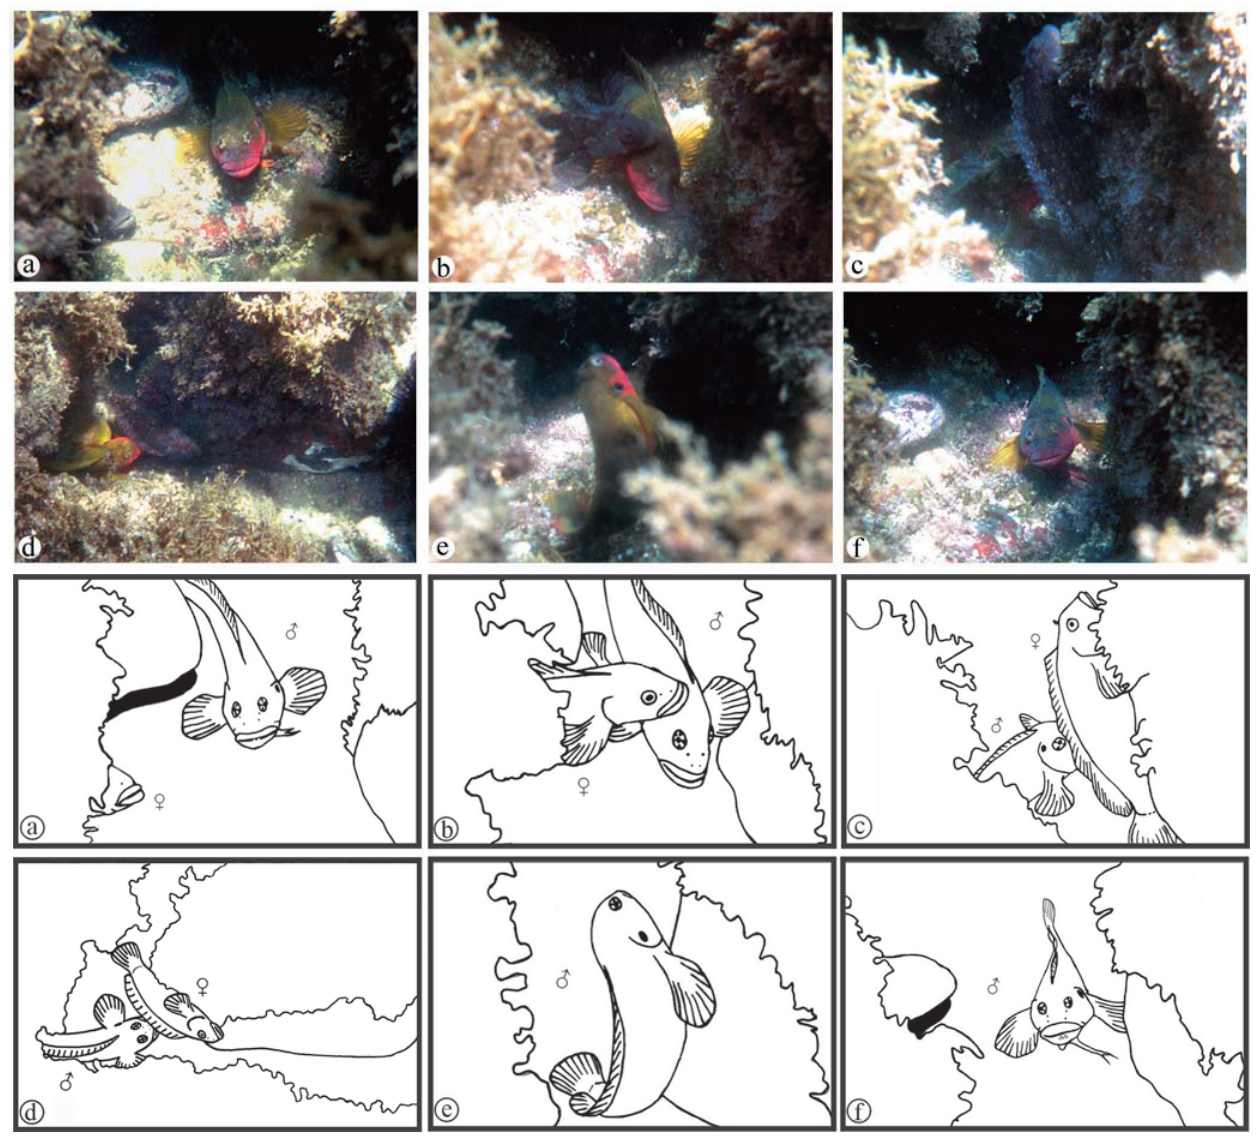
Fig. 1. A couple of Labrisomus nuchipinnis (about 150 mm TL) engaged in a “mating cycle” at São Sebastião Channel, São Paulo, southeastern Brazil. Photos and drawings: FZG &